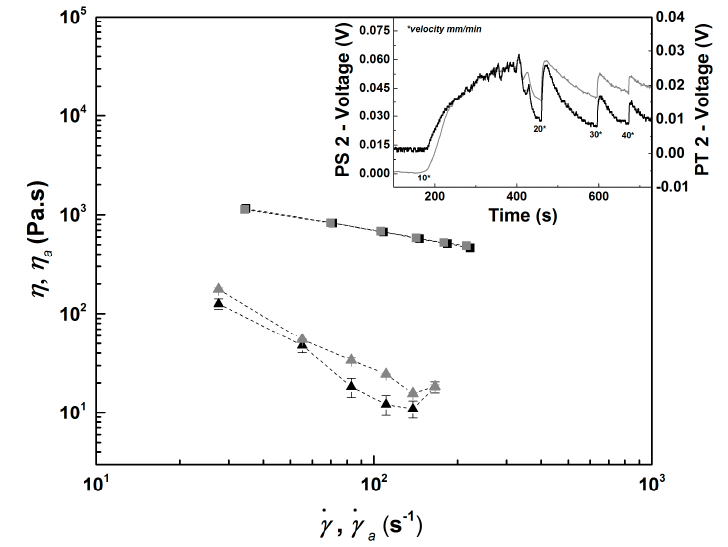
Figure 10. Flow curves measured with polybutylene adipate terephthalate (PBAT) at 180 ◦ C (squares) and polyhydroxybutyrate (PHB) at 190 ◦ C (triangles). Comparison between piezoelectric sensors (symbols and lines in grey) and conventional pressure transducers (symbols and lines in black). The inset represents the time evolution of outputs (voltages) measured with PHB by sensors located upstream during the stepwise ramp in the piston velocity of the capillary rheometer.